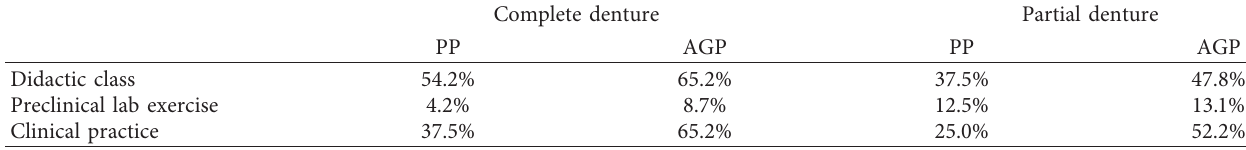
Table 1: Implementation of CAD-CAM denture in the